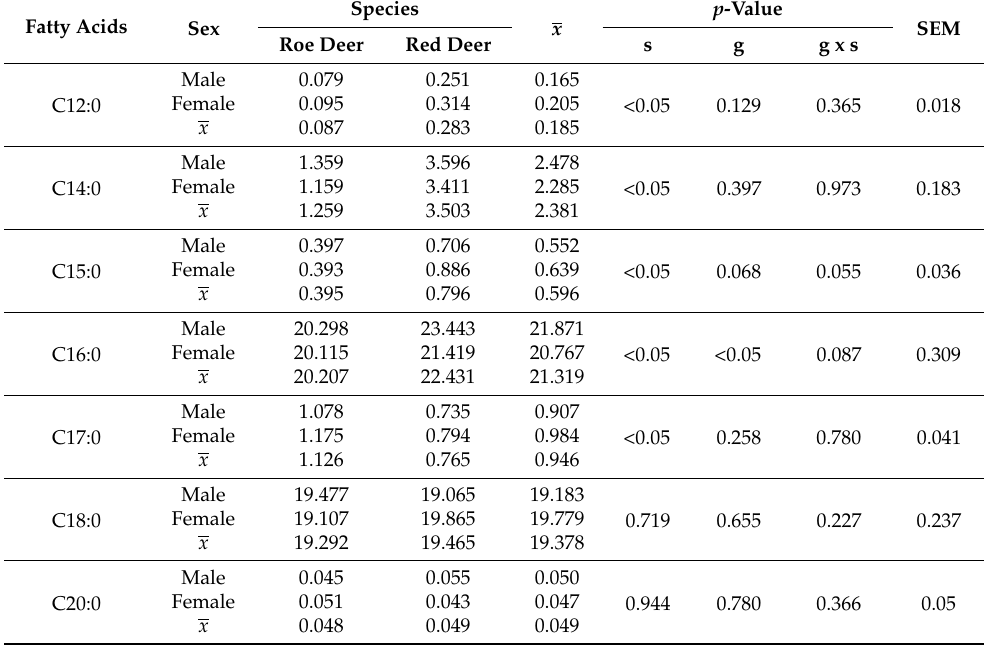
Table 3. Saturated fatty acids profile (% total) of musculus